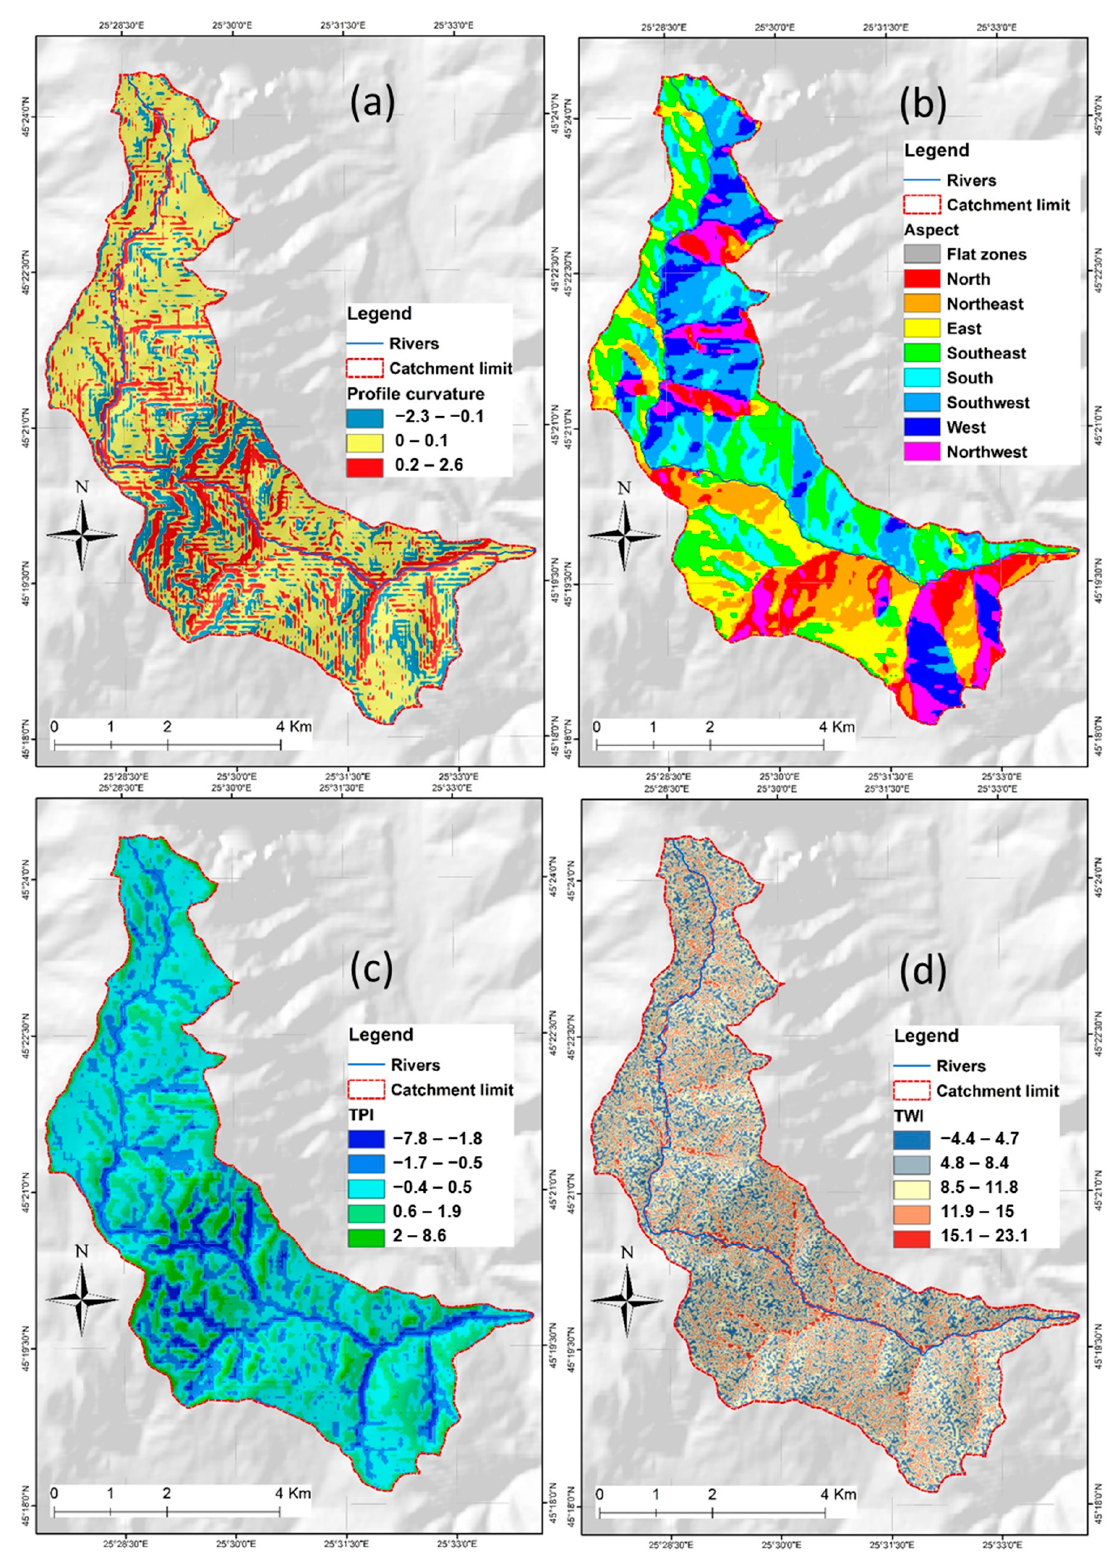
Figure 3. Flash-flood and flood predictors. ( a ) Profile curvature; ( b ) Aspect; ( c ) Topographic position index (TPI); ( d ) Topographic Wetness Index TWI.